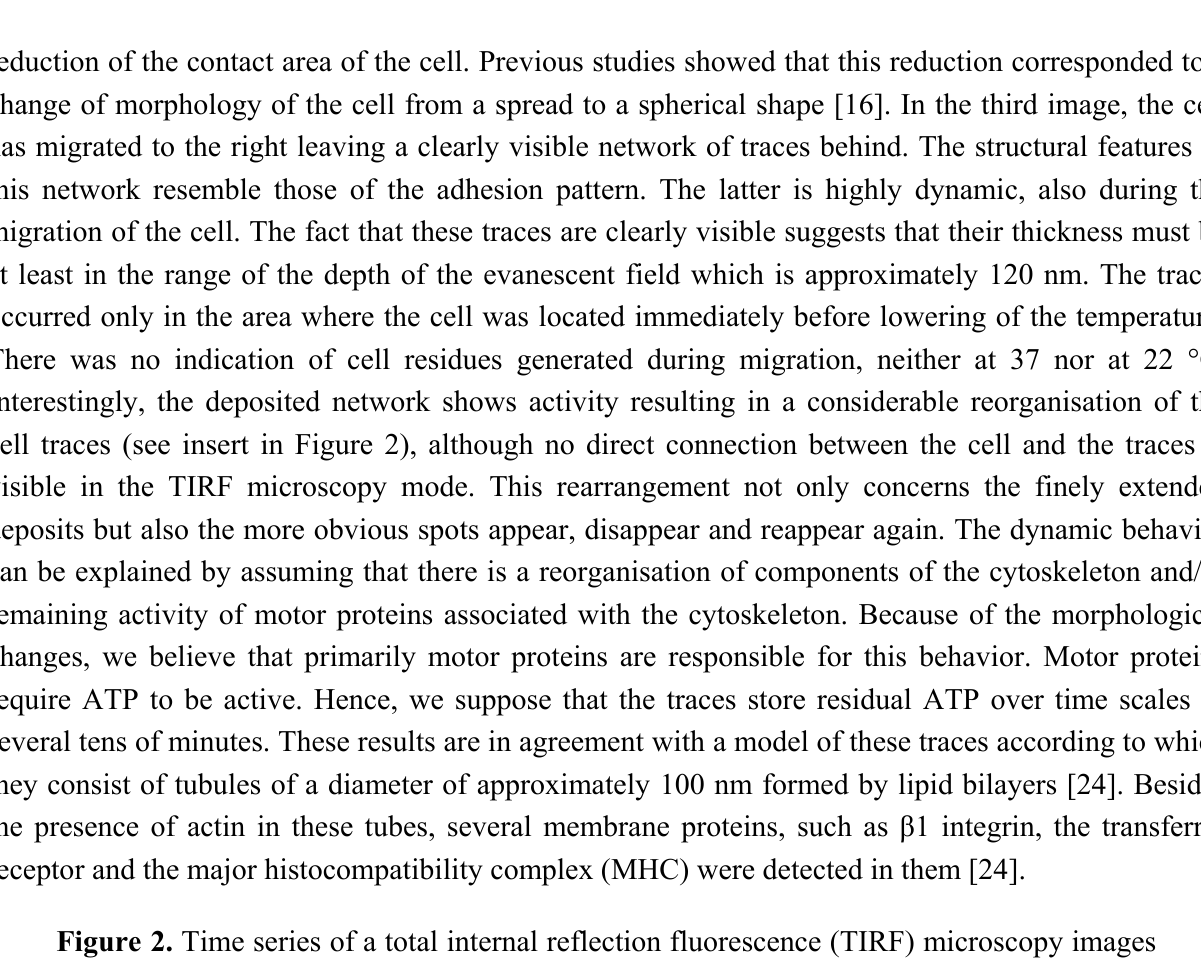
Figure 2. Time series of a total internal reflection fluorescence (TIRF) microscopy images (contrast enhanced) at different times during cell detachment (L929 mouse fibroblast) upon cooling a thermoresponsive substrate. The fibroblast left cell material on the substrate. The cell traces were rearranging themselves throughout the observation time of 60 min (compare inserts taken at 44 and 45 min, and at 50 and 51